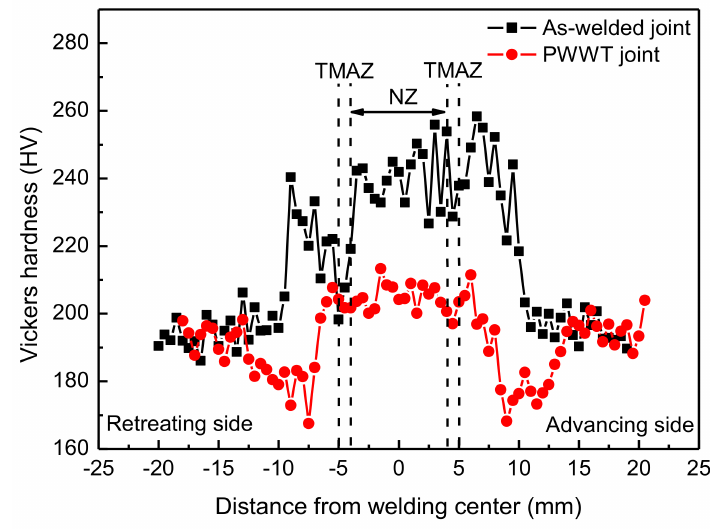
Figure 2. Hardness profile along the transverse direction in the as-welded and PWHT joints.